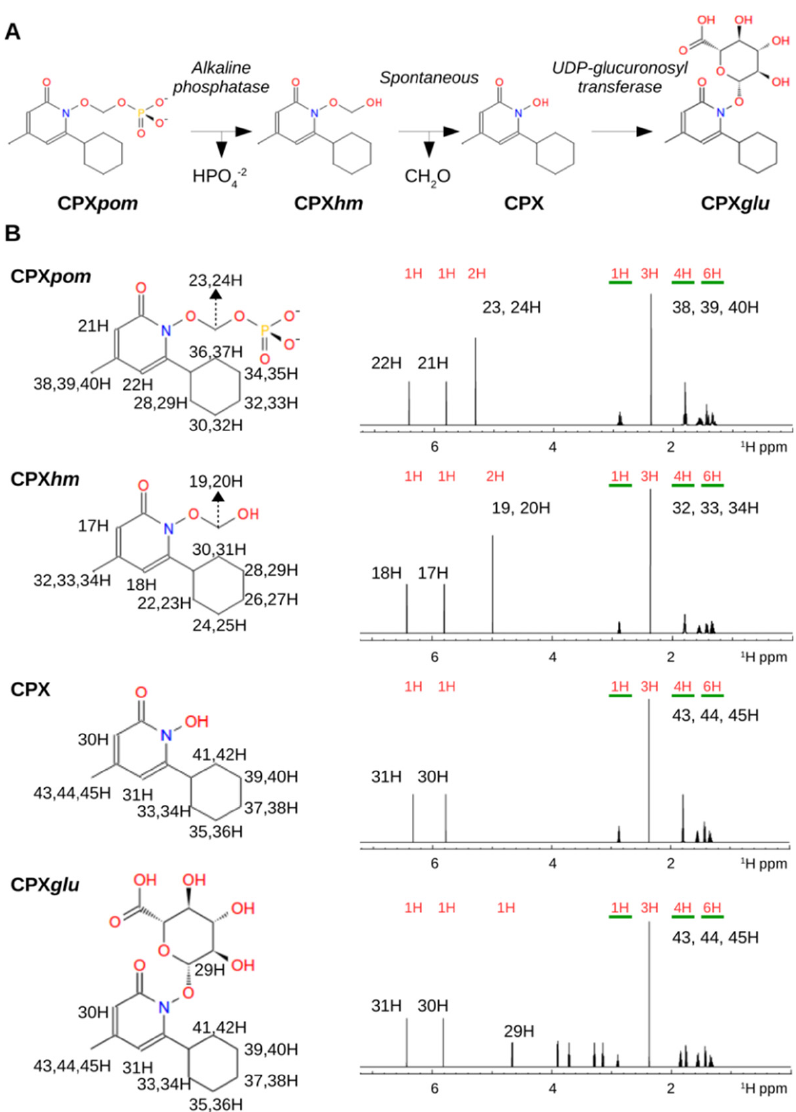
Figure 3. ( A ) CPX pom catabolic pathway involving direct phase II biotransformation. ( B ) Theoretical NMR spectra where the expected signals for the different species are shown.